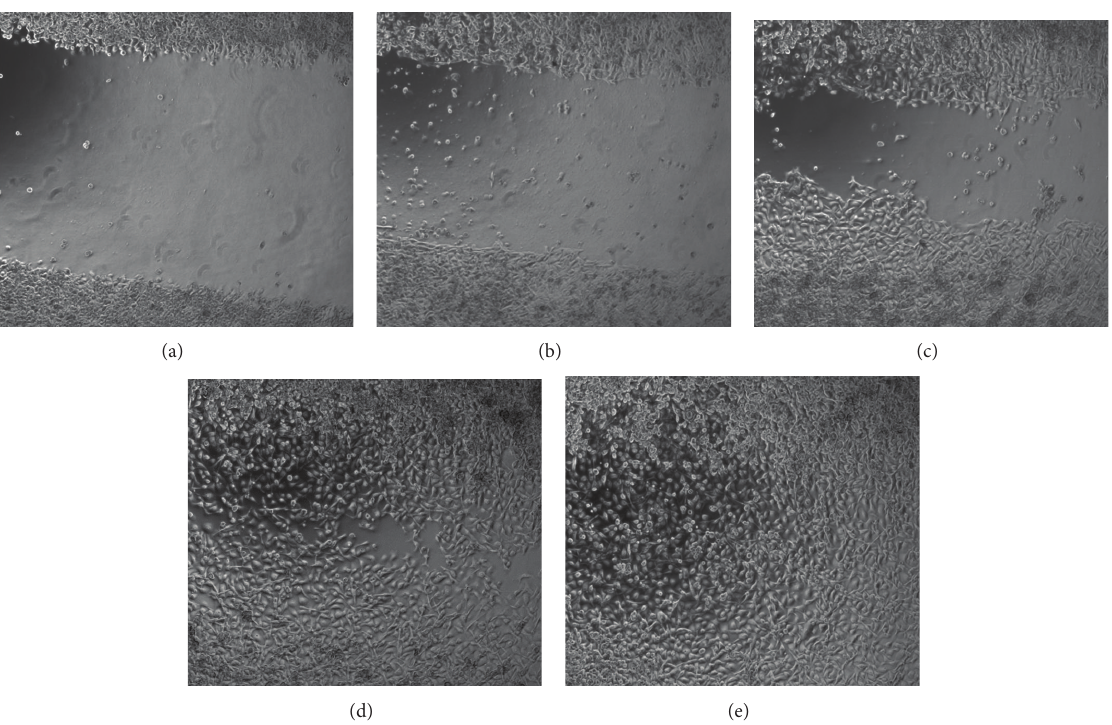
Figure 2: Representative micrographs of a challenge with different numbers of heat-killed P. gingivalis and control medium. (a) Original scratch (b)–(e) after 17h incubation, (b) MOI 1000 heat-killed P. gingivalis , (c) MOI 100 heat-killed P. gingivalis , (d) MOI 10 heat-killed P. gingivalis , and (e) control medium.